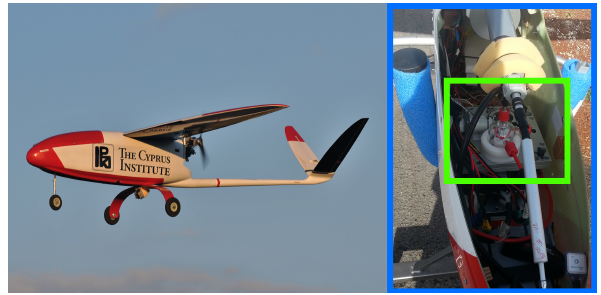
Figure 6. The Cruiser UAS with the multi-sample aerosol collector (green rectangle; photograph by Kjell-Sture